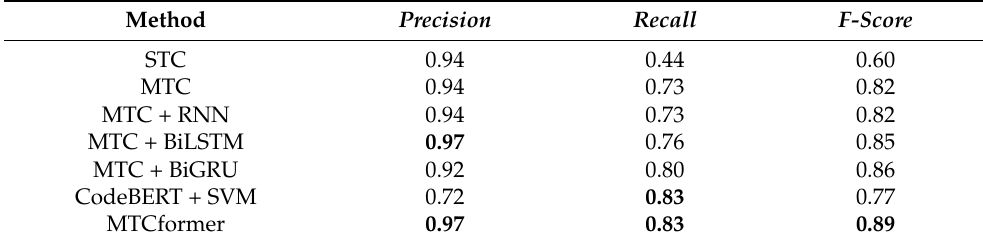
Table 2. The performance of different variant